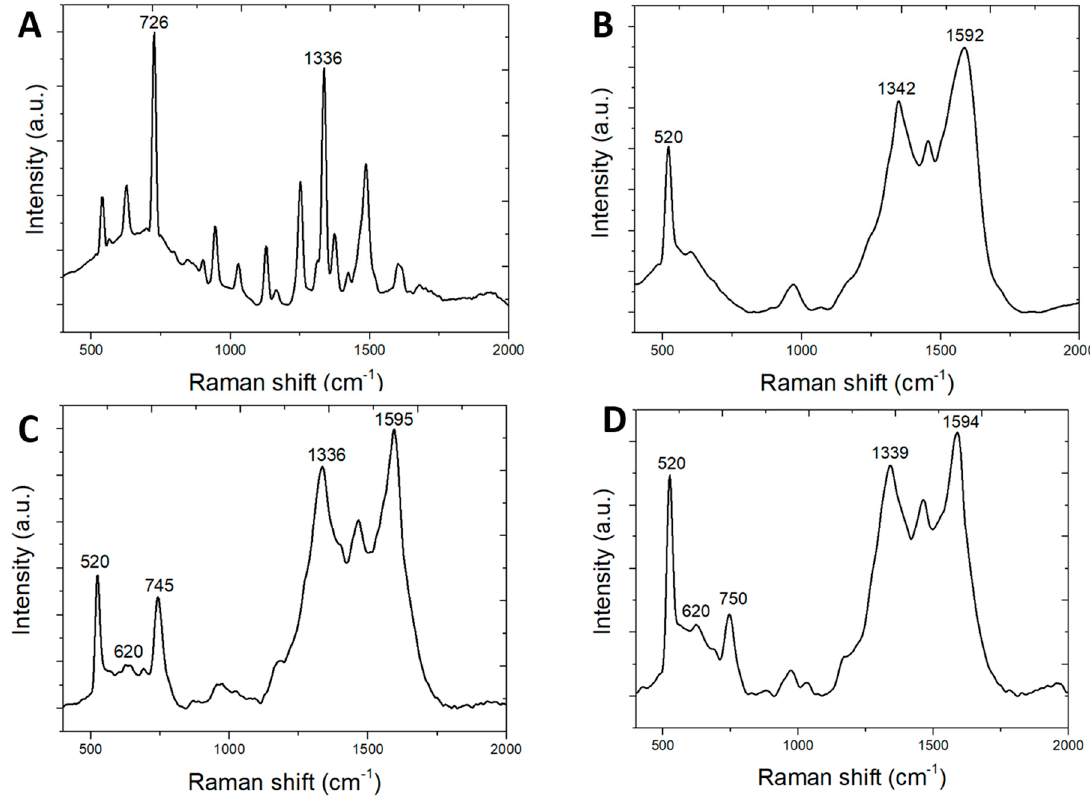
Figure 4. Raman and surface-enhanced Raman scattering (SERS) spectra. ( A ) Raman spectrum of adenine powder used for this study. ( B ) SERS spectrum of deionized water without adenine. ( C ) SERS spectrum of adenine powder wetted by deionized water. ( D ) SERS spectrum of saturated concentration of adenine in water.